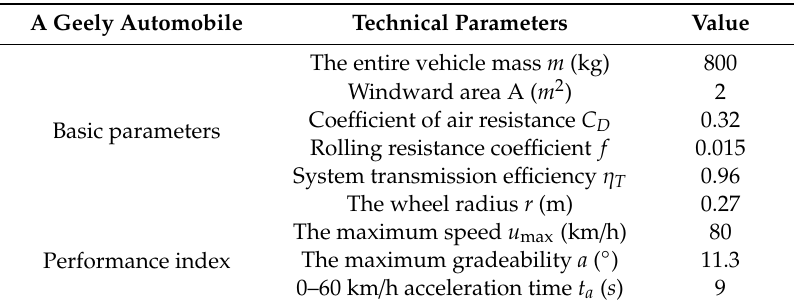
Table 1. Parameters of a Geely